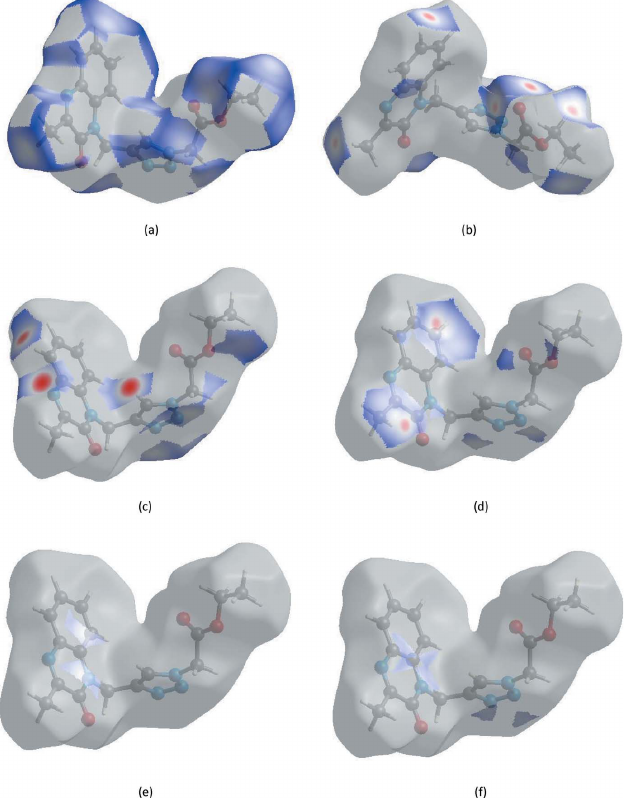
Figure 8 Hirshfeld surface representations with the function d norm plotted onto the surface for ( a ) H (cid:3)(cid:3)(cid:3) H, ( b ) H (cid:3)(cid:3)(cid:3) O/O (cid:3)(cid:3)(cid:3) H, ( c ) H (cid:3)(cid:3)(cid:3) N/N (cid:3)(cid:3)(cid:3) H, ( d ) H (cid:3)(cid:3)(cid:3) C/ C (cid:3)(cid:3)(cid:3) H, ( e ) C (cid:3)(cid:3)(cid:3) C and ( f ) C (cid:3)(cid:3)(cid:3) N/N (cid:3)(cid:3)(cid:3) C interactions.